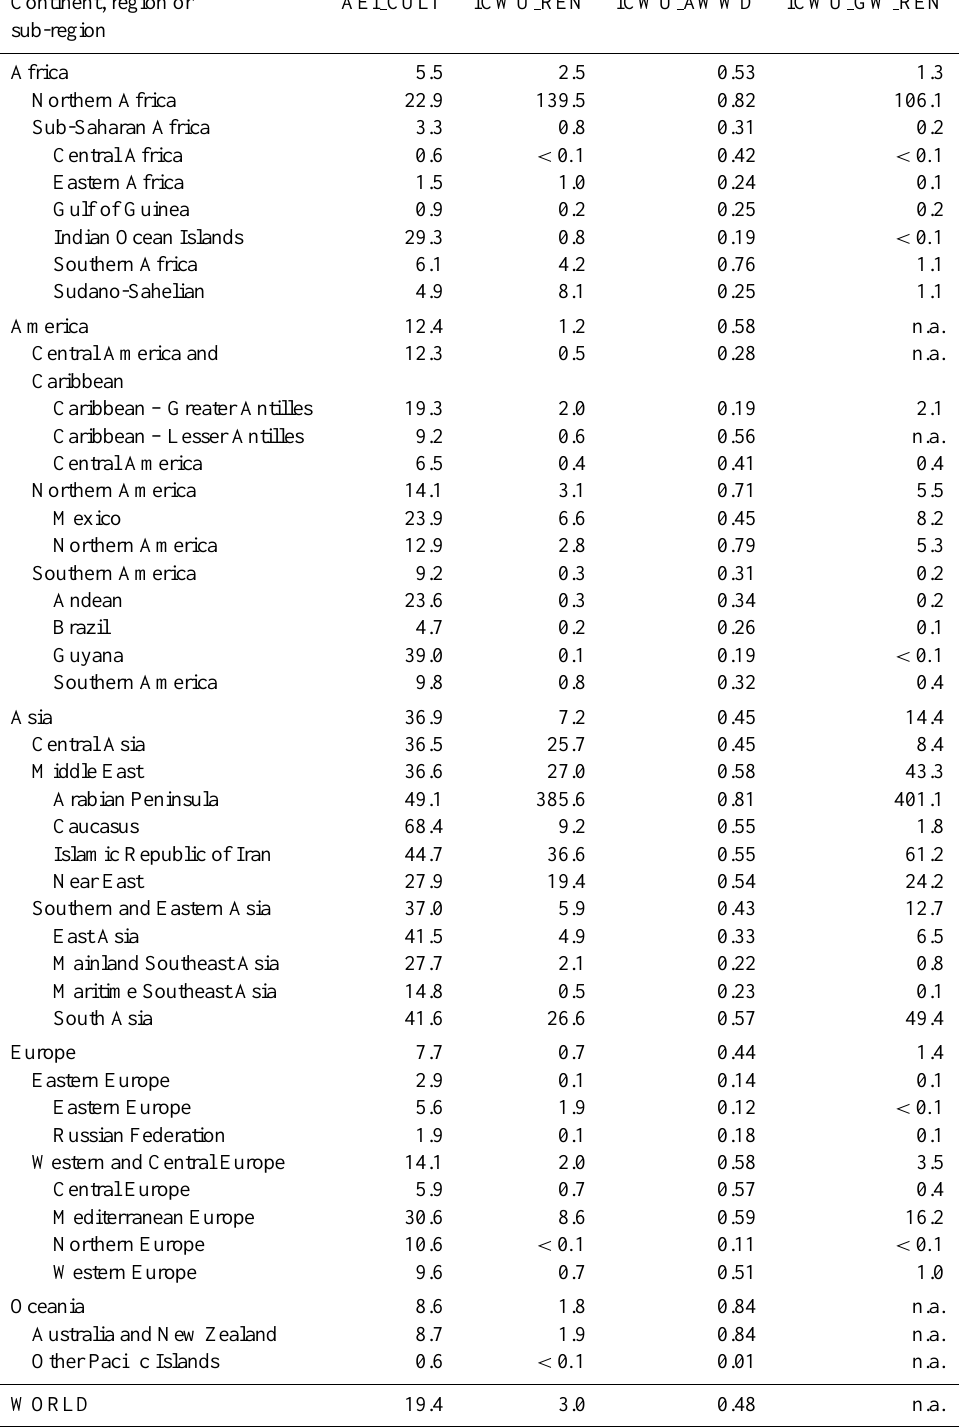
Table 3. Area equipped for irrigation as percentage of cultivated land (AEI CULT), consumptive irrigation water use as percentage of total internal renewable water resources (ICWU REN), consumptive irrigation water use as fraction of agricultural water withdrawals (ICWU AWWD) and consumptive groundwater use for irrigation as percentage of internally produced groundwater (ICWU GW REN) per continent, region and sub-region (cultivated land, internal renewable water resources, agricultural water withdrawals and internally produced groundwater per country was derived from the FAO AQUASTAT main country database, http://www.fao.org/nr/water/aquastat/data/query/ index.html?lang=en, last access: 16 March